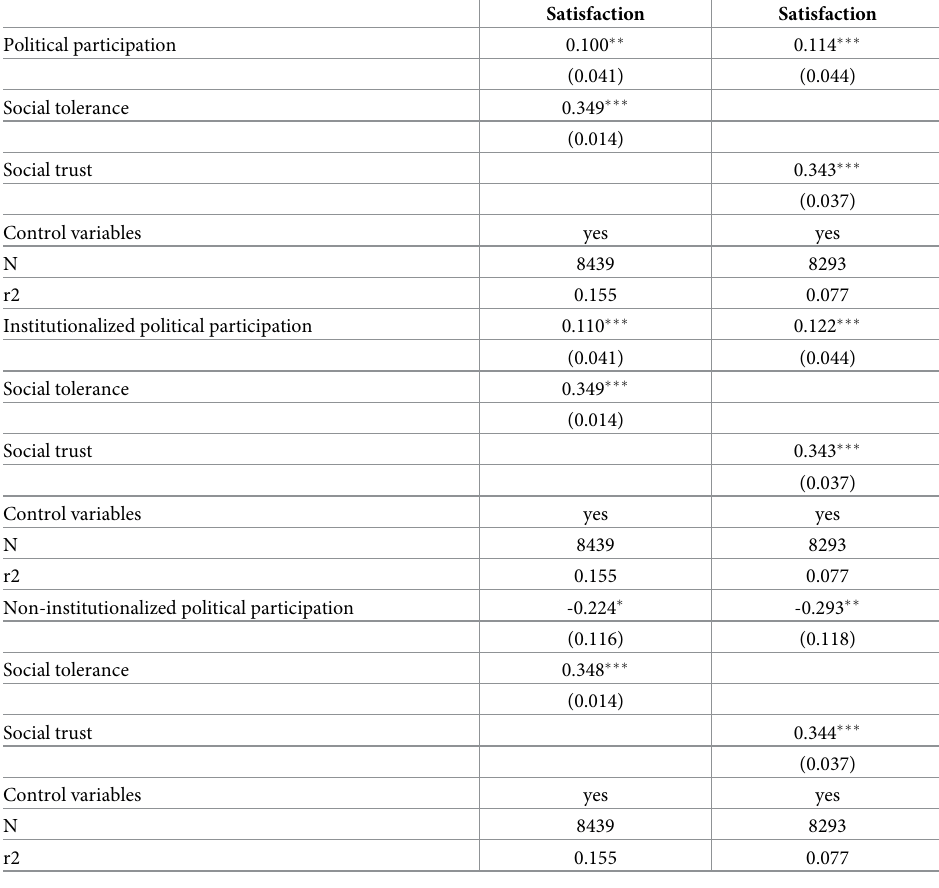
Table 7. Estimation results after adding independent and mediating